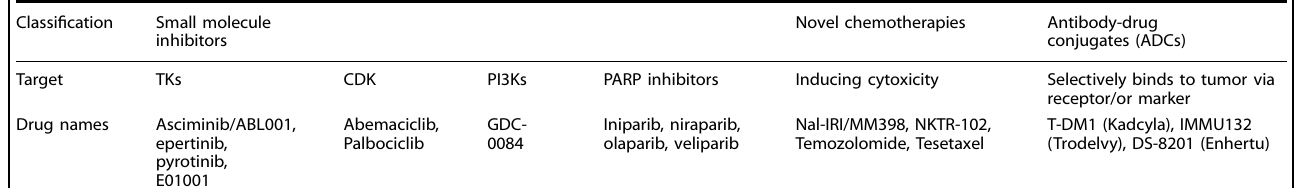
Table 2. Standard and emerging alternatives to current chemotherapies for patients with BCBM: Tyrosine kinase inhibitors 92 – 95 , CDKi 96 , PI3Ki 97